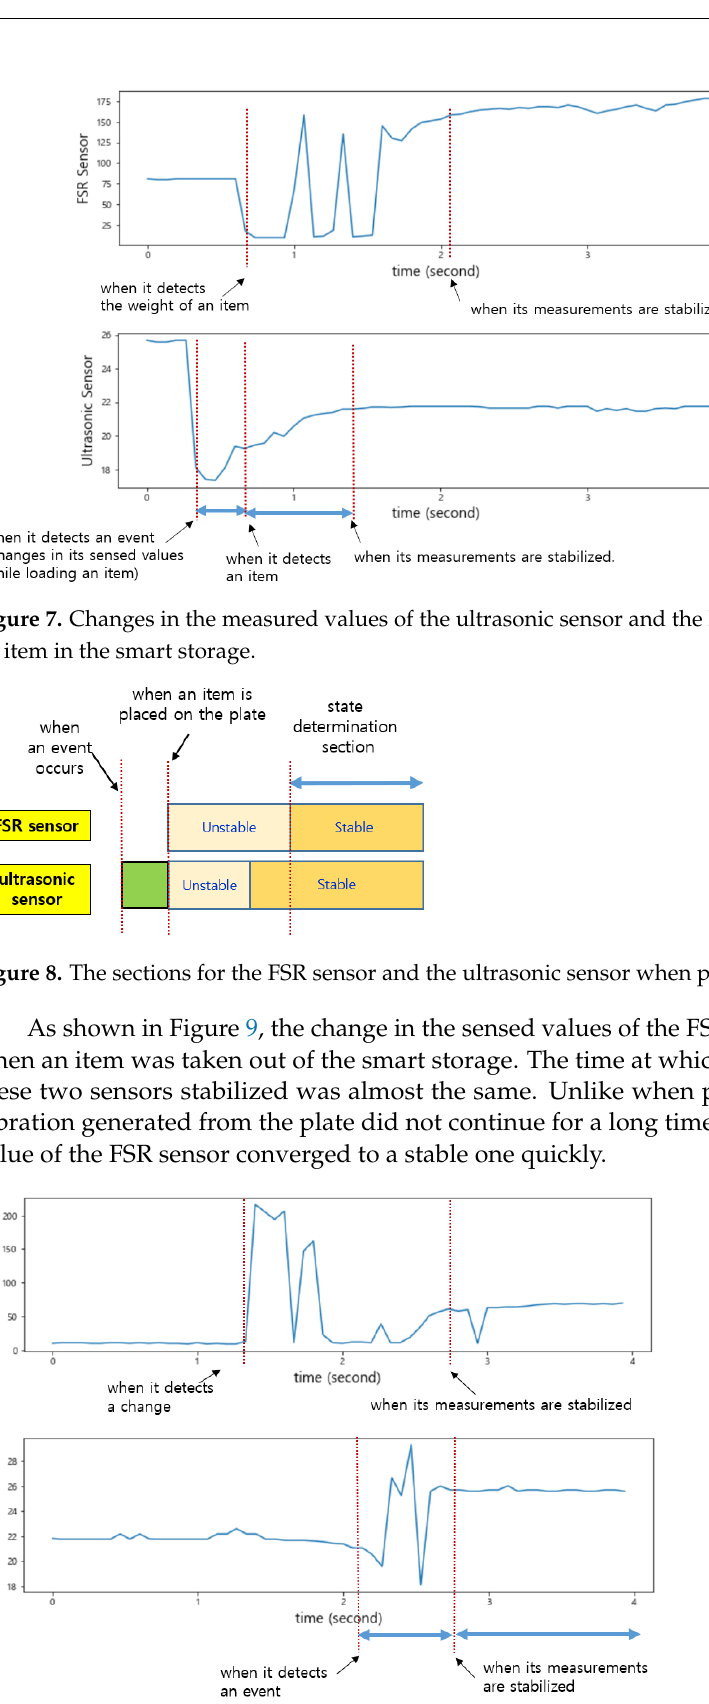
Figure 9. Changes in the measured values of the ultrasonic sensor and the FSR sensor when an item was taken out of the smart storage. was taken out of the smart